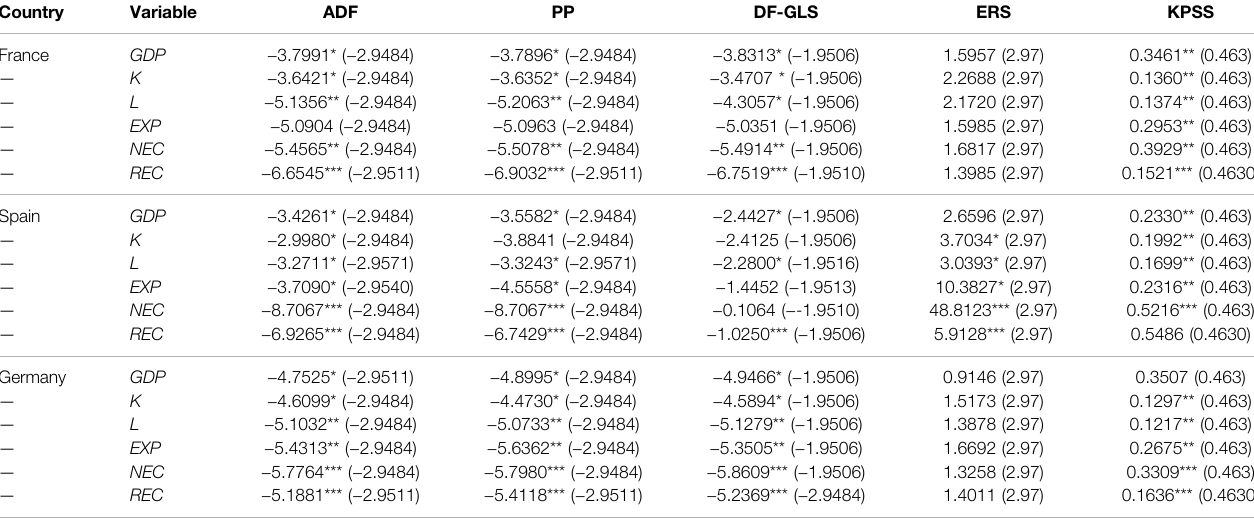
TABLE 6 | Results of the unit root tests for fi rst difference series. Country